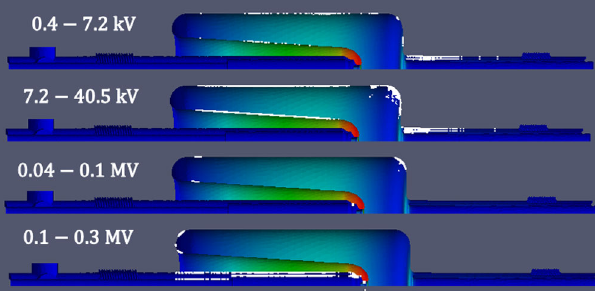
FIG. 10. Areas of the gun affected by multipacting (shown in white). Primary electrons are emitted from the surface of the cavity.